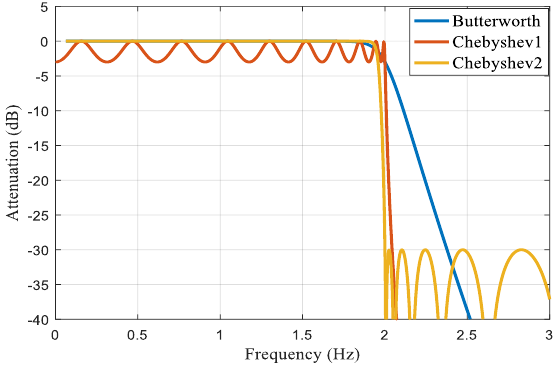
Fig. 2. Step response of the Butterworth and Chebyshev